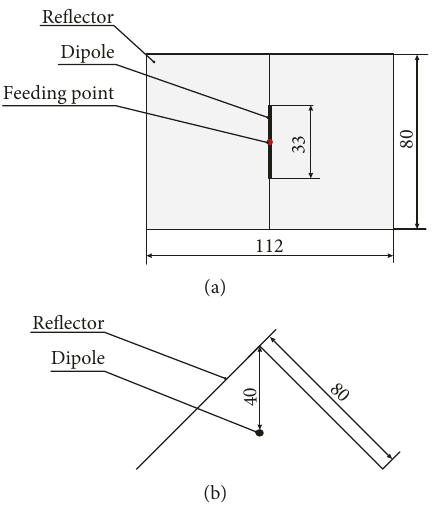
Figure 5: Dimensions of the corner re fl ector antenna used for simulations using the FDTD method (given in mm): (a) front view; (b) top